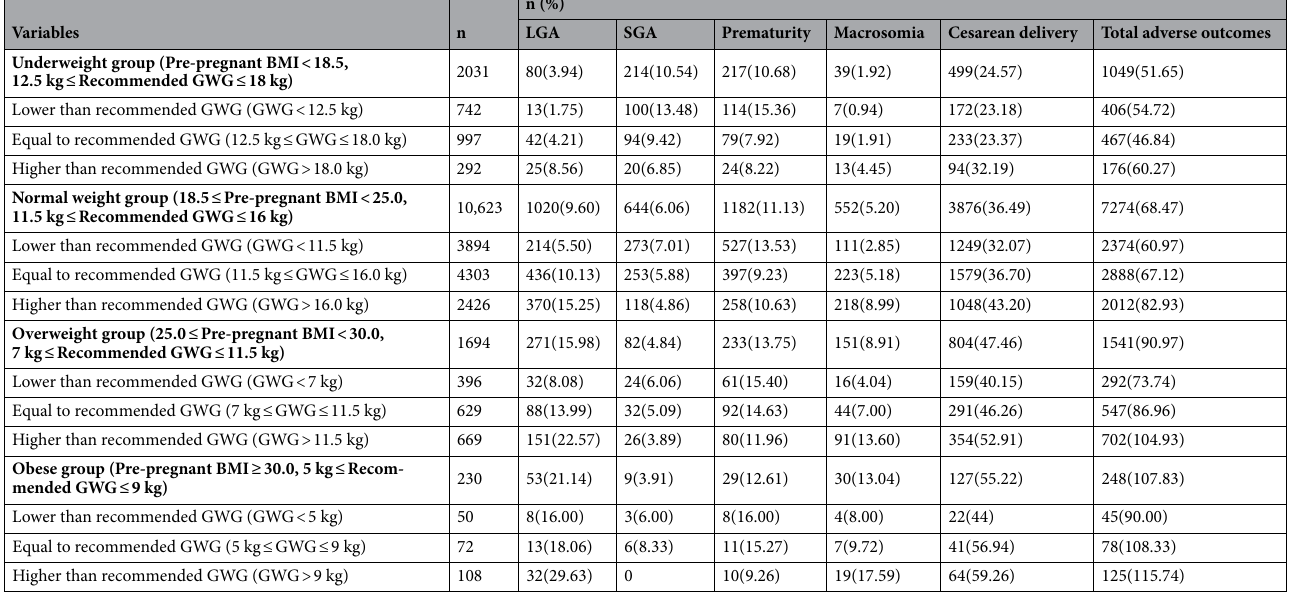
Table 3. The risks of maternal or infant adverse outcomes of participants (n = 14,578). BMI body mass index, GWG Gestational weight gain, LGA large for gestational age, SGA small for gestational